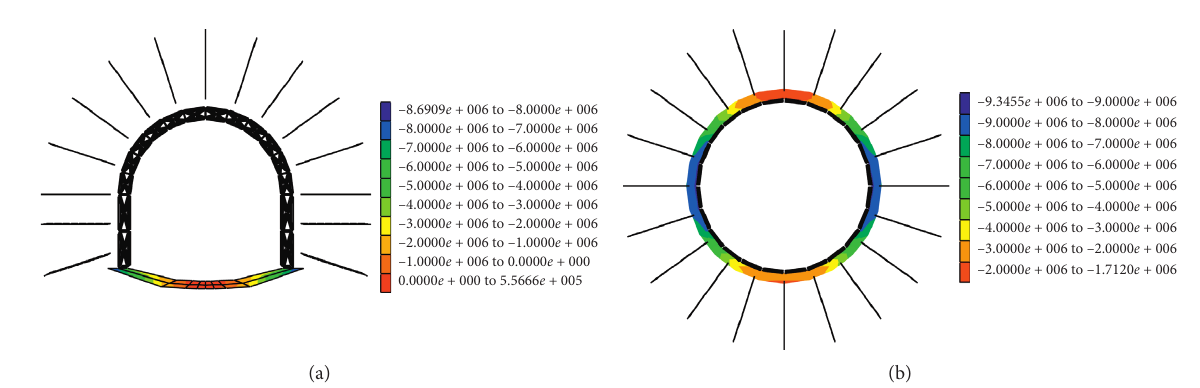
Figure 8: Floor stress contours of roadway in excavation of 6m. (a) Semicircular arch roadway. (b) Circle